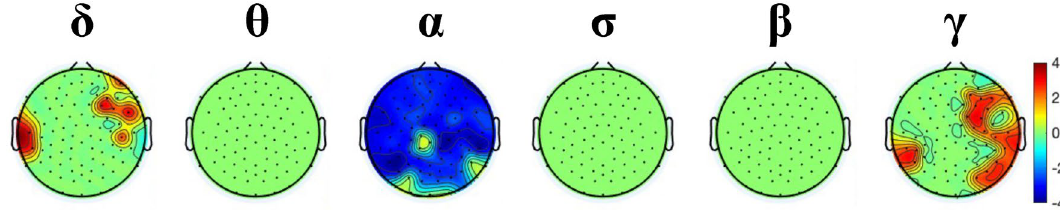
Figure 2. Statistical comparison of channels’ power spectral density (PSD) between resting-state and cold pressor test (CPT) in the δ (1–4 Hz), θ (4–8 Hz), α (8–12 Hz), σ (12–16 Hz), β (16–30 Hz) and γ (30–45 Hz) bands, conducted with a Student t-test ( p < 0.05 , corrected with cluster-correction). Each scalp map represent the distribution of t-values for which the comparison was significant. Positive t-values indicate higher power during CPT, with respect to resting-state, whereas negative t-values indicate lower power during CPT, with respect to resting-state.